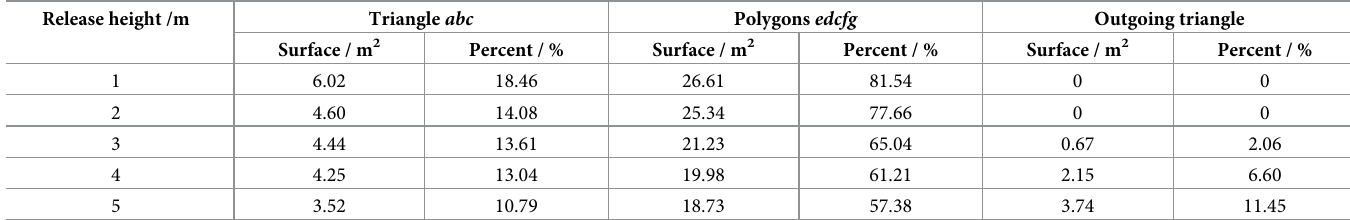
Table 2. Projection area and discharge rate of each part of the coal